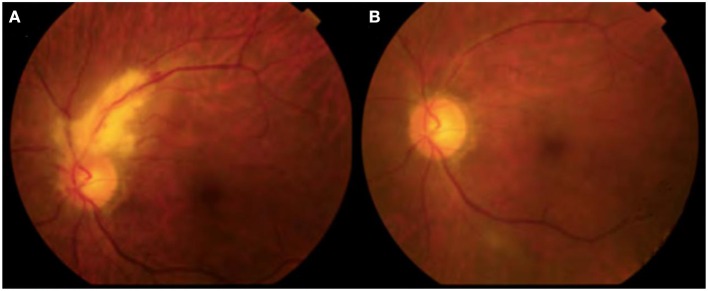
CMVR persons of PLHIVs before and after treatment of ophthalmoscopy. (A) Before HAART; (B) After 2 weeks of HAART.